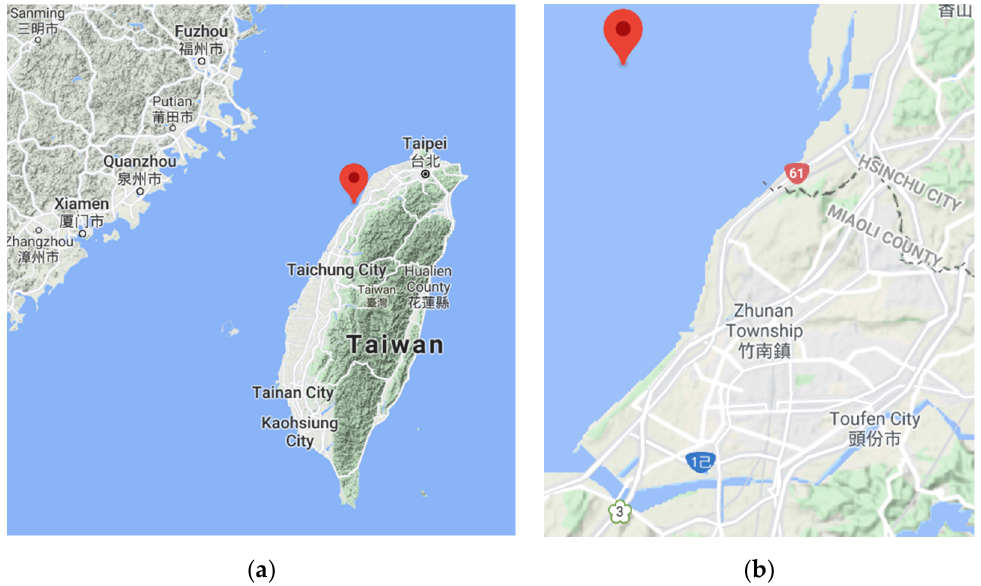
Figure 1. ( a ) Location of the met mast (marked with a red pin); ( b ) the met mast and the coast area.